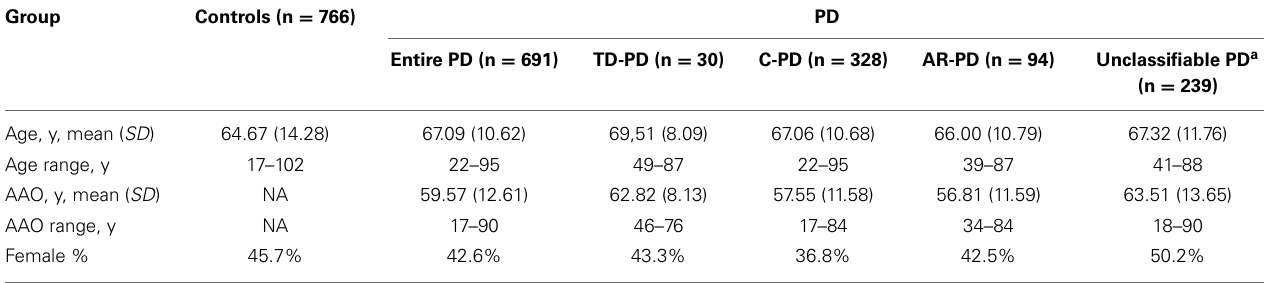
Table 1 | Demographic data of the sample analyzed in this